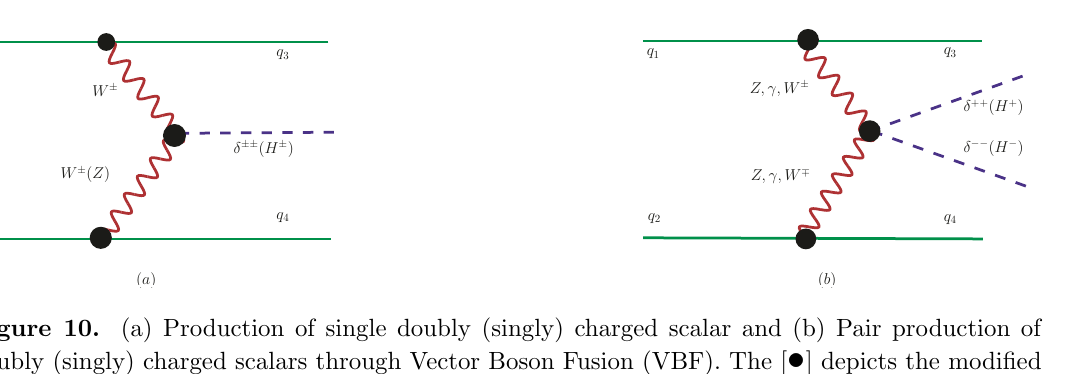
] depicts the modi(cid:12)ed (cid:15)